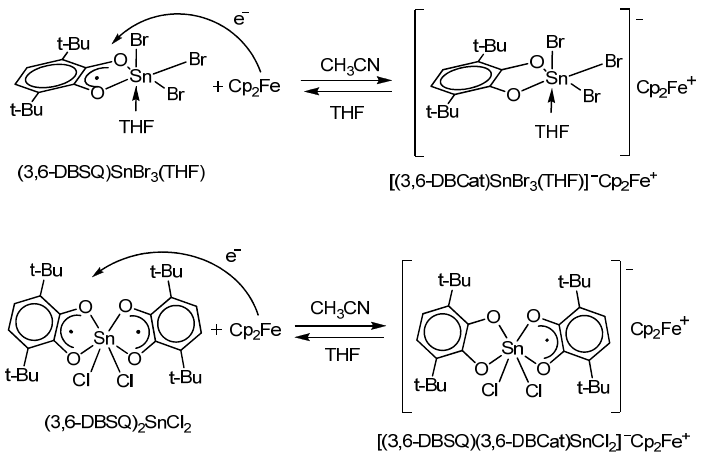
Scheme 9. The reduction of mono- and di-o-benzosemiquinonato tin(IV) halides with ferrocene